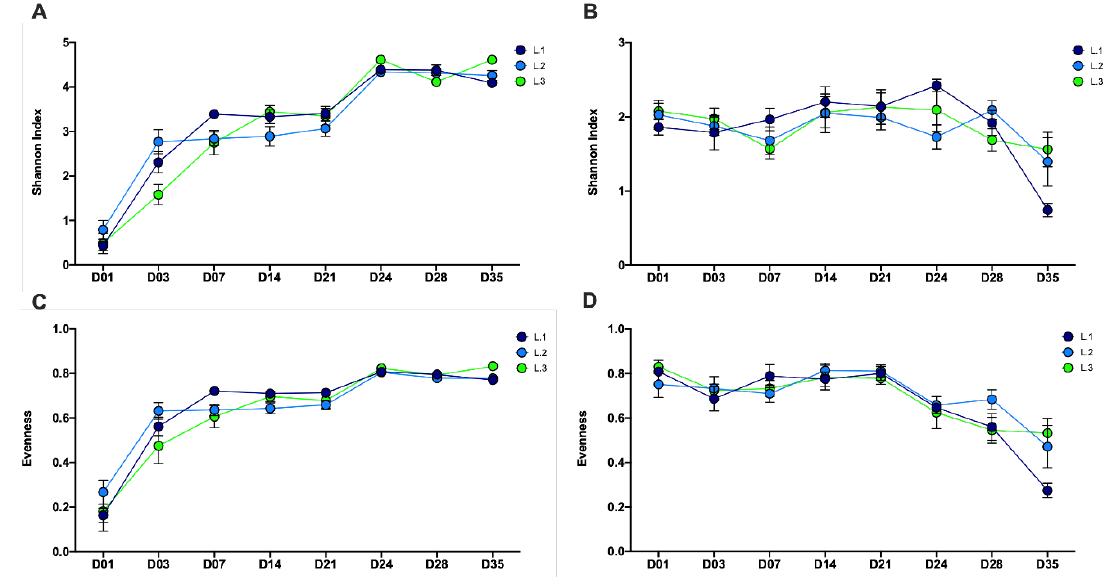
Figure 1. Alpha-diversity of the bacteriome and mycobiome in piglet feces over time. Shannon diversity index values for the ( A ) bacteriome and ( B ) mycobiome and evenness values for the ( C